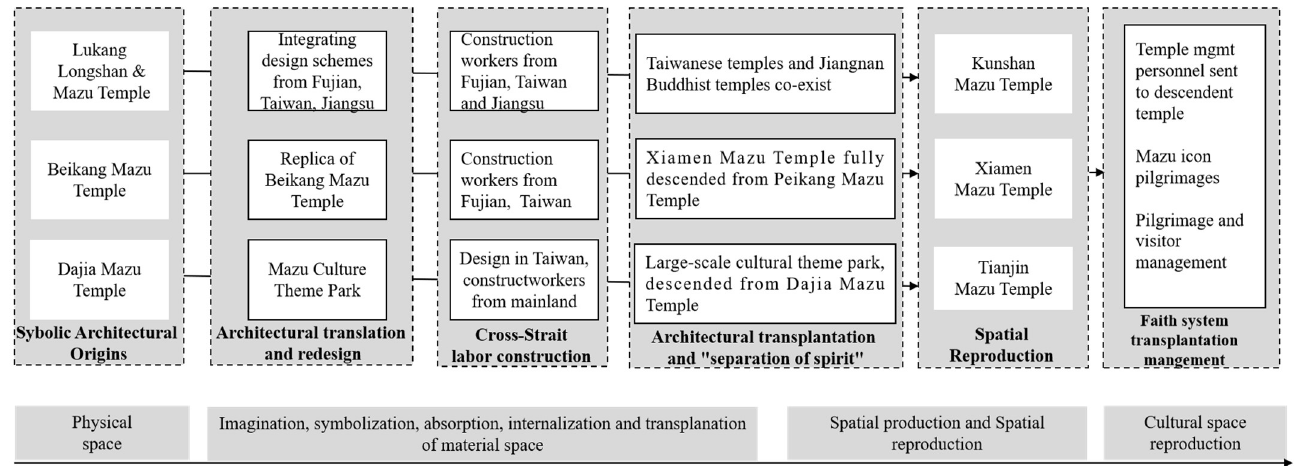
Figure 5. Physical practice and space production of three Mazu temples. Source: Compiled by au- thors.